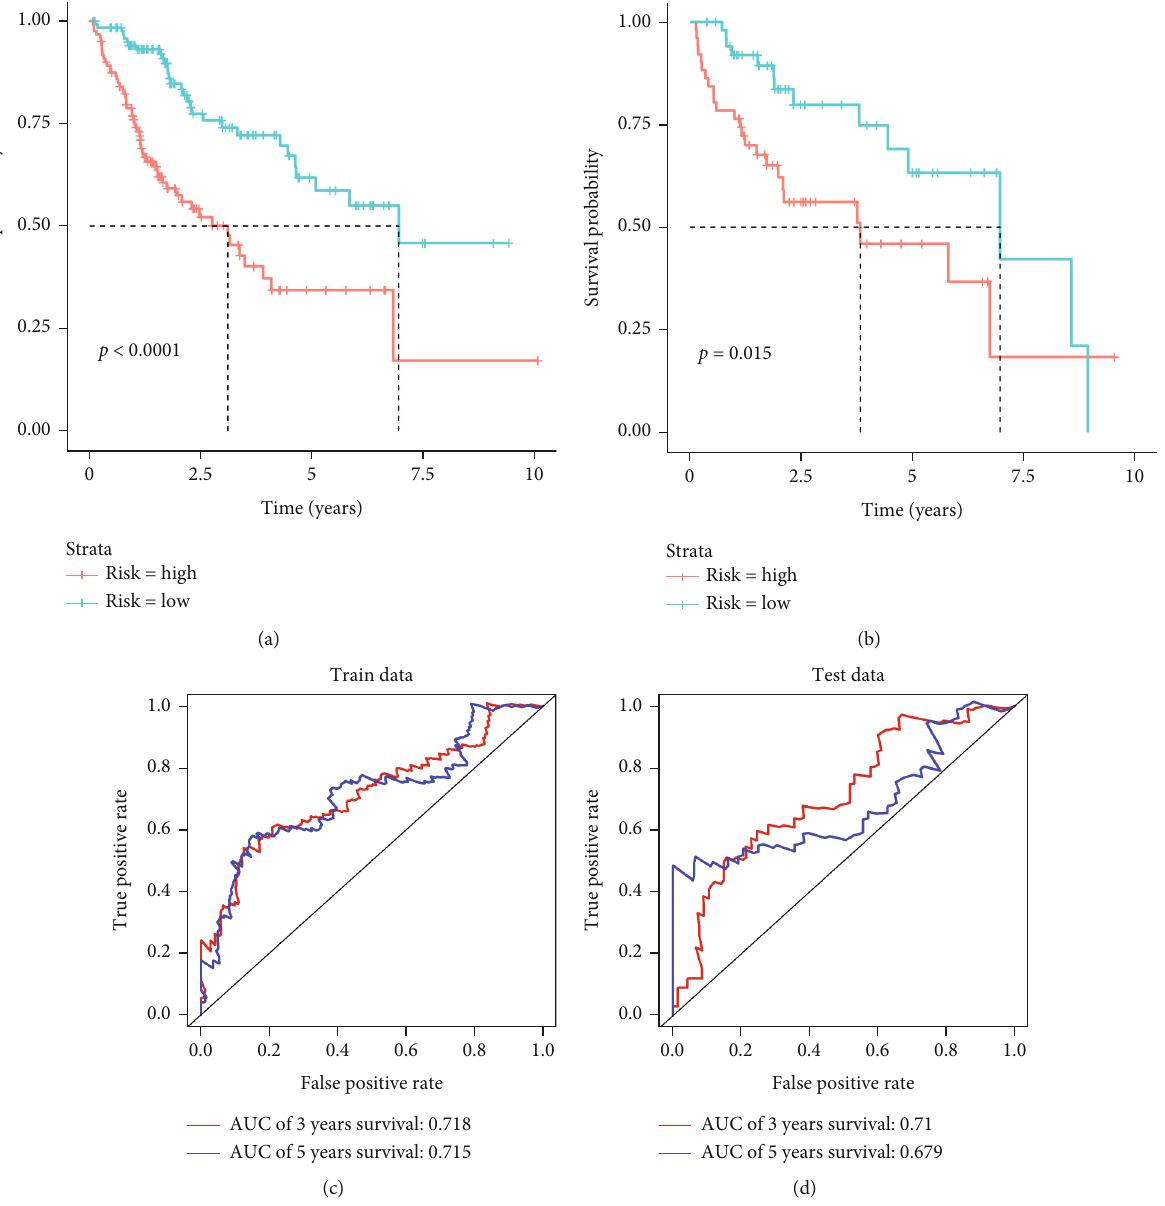
Figure 4: 5-Gene model prediction ability assessment. K - M survival curves of patients in the high- (red) and low-risk (green) groups in training set (a) and validation set (b). (c) ROC curves for the training set 5-gene prognostic model. (d) ROC curves for the validated set 5-gene prognostic